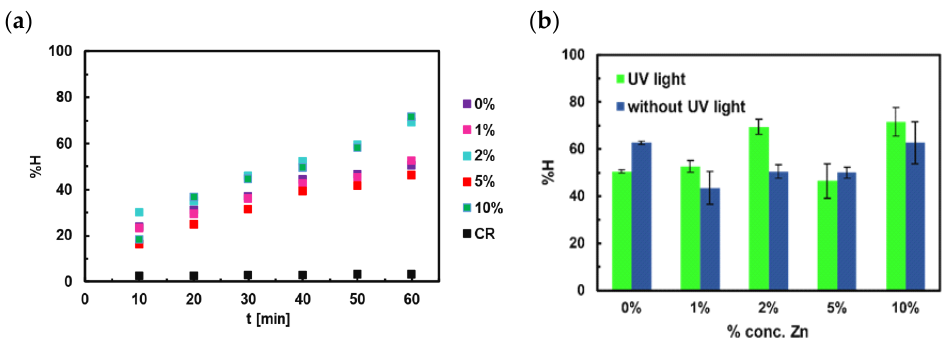
Figure 20. Efficiency of ( a ) photodegradation process by Fe 3 O 4 , Fe 3 O 4 @1%Zn, Fe 3 O 4 @2%Zn, Fe 3 O 4 @5%Zn, and Fe 3 O 4 @10%Zn nanoparticles after 60 min exposure time of Congo red and pristine dye, and ( b ) photo-assisted removal of CR in pH 6.